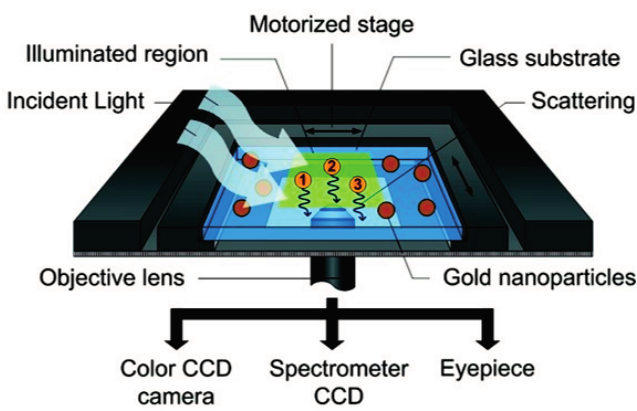
Figure 3. Schematic diagram of the optical setup for the detection of the gold nanoparticles in a nanoarray, where the scattered light is directed to a colour CCD, spectrometer CCD and the eyepiece. The nanoarray is spectroscopically analysed by scanning along the region-of-interest in sequential steps. The single-particle spectral information is then recreated into a pseudo-image for further analysis. Adapted with permission from